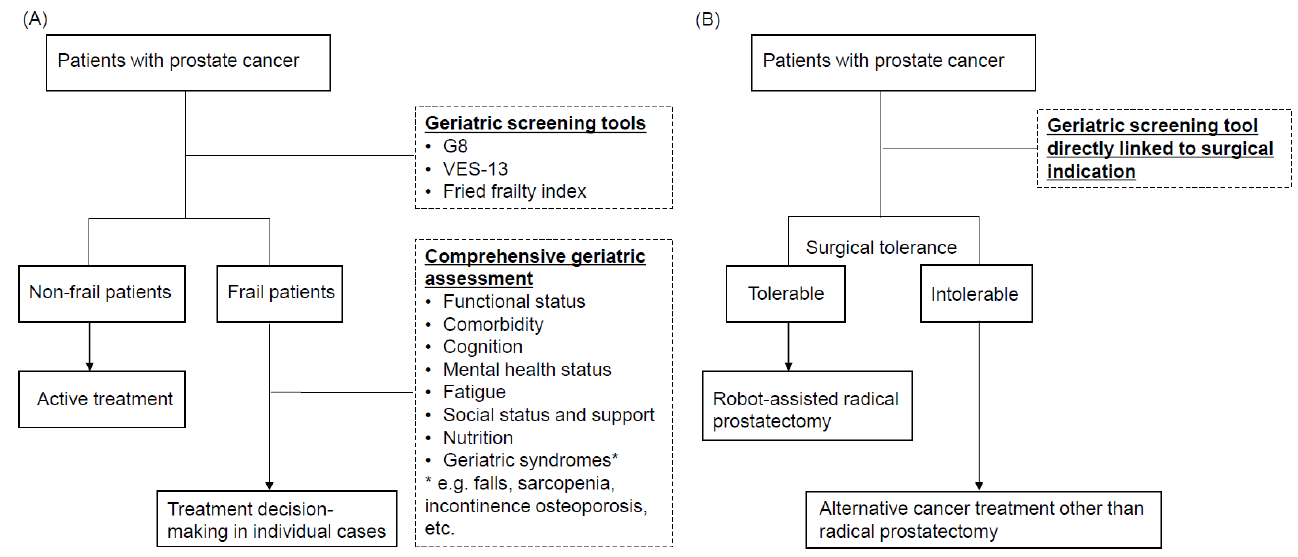
Figure 1. Flowcharts showing recommended use of geriatric tools in decision-making of treatment for prostate cancer. ( A ) Use of geriatric screening tools and comprehensive geriatric assessment in status quo. ( B ) Future perspective of direct use of geriatric screening tool to determine surgical tol- erability.